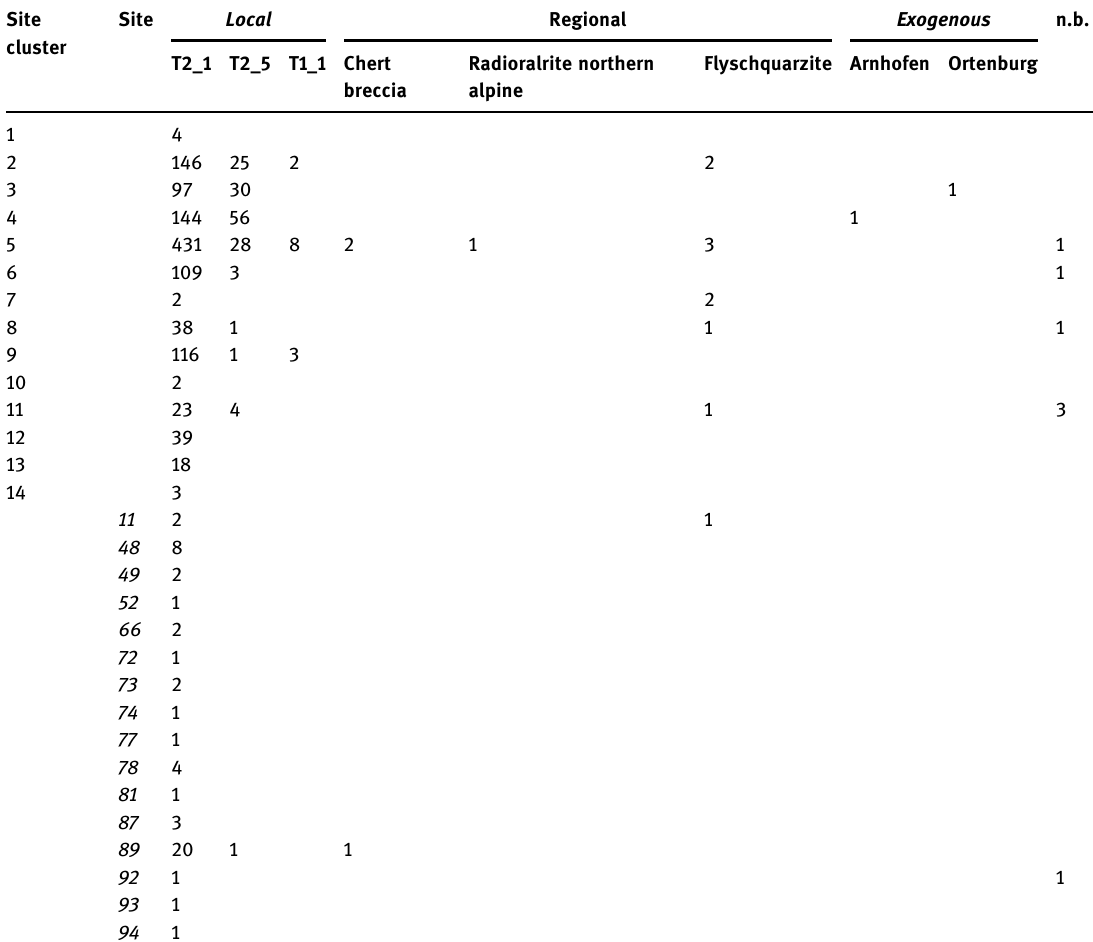
Table 13: Raw material varieties sur fi cial